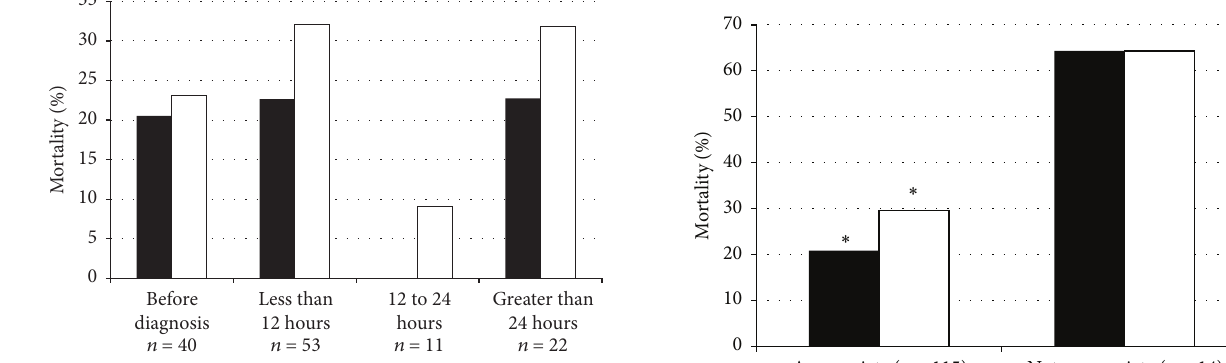
Figure 3: ICU and hospital mortality related to antibiotic initiation time. There was no significant difference in ICU mortality ( ◼ ; 𝑝 = 0.37 ) and in hospital mortality ( ◻ ; 𝑝 = 0.47 ) between the four antibiotic initiation time groups. Data presented as percentages.